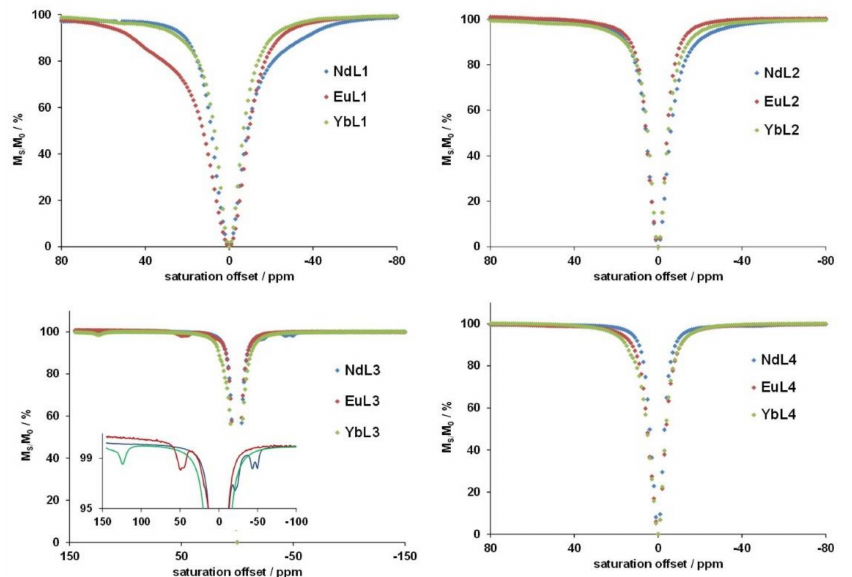
Figure 2. CEST spectra of LnL1, LnL2, LnL3 and LnL4 complexes recorded at 400 MHz, pH 7.4, 298 K, using a pre-saturation pulse of 3 s at 25 µ T (10 mW). The concentration of the samples were: [EuL1] = 82 mM, [EuL2] = 54 mM, [EuL3] = 18 mM, [EuL4] = 18 mM, [NdL1] = 90 mM, [NdL2] = 83 mM, [NdL3] = 18 mM, [NdL4] = 17 mM, [YbL1] = 90 mM, [YbL2] = 82 mM, [YbL3] = 16 mM, [YbL4] = 19